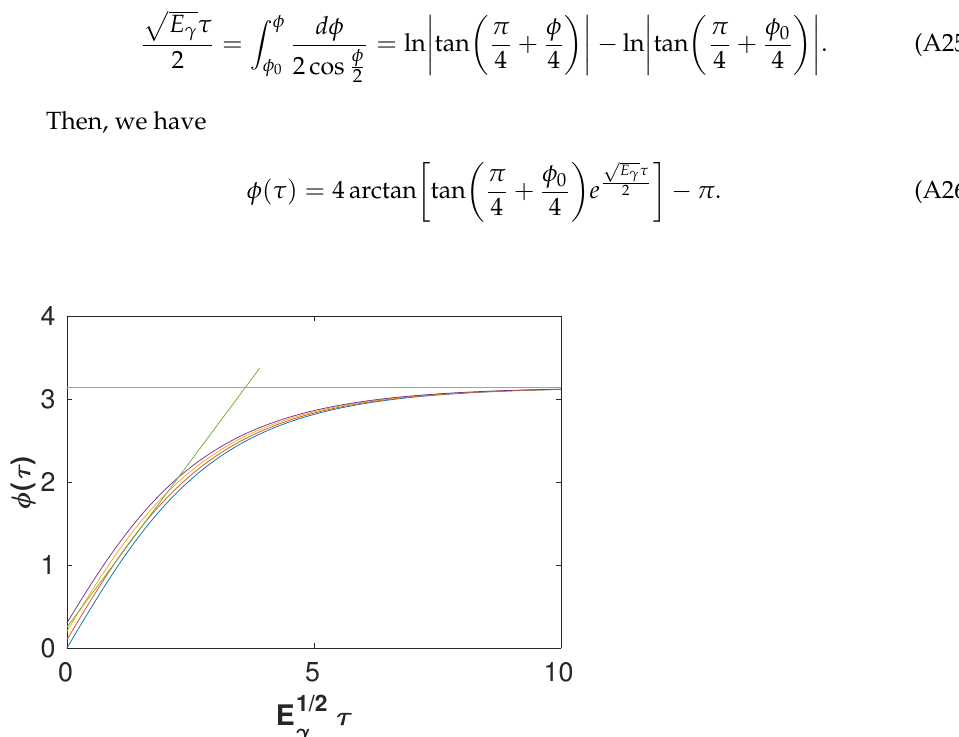
(cid:112) E γ τ ∈ [ 0,10 ] and φ 0 = 0,0.1,0.2,0.3. The linear